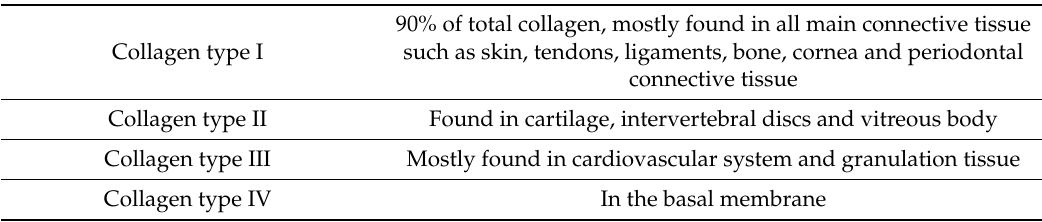
Table 1. Main types of